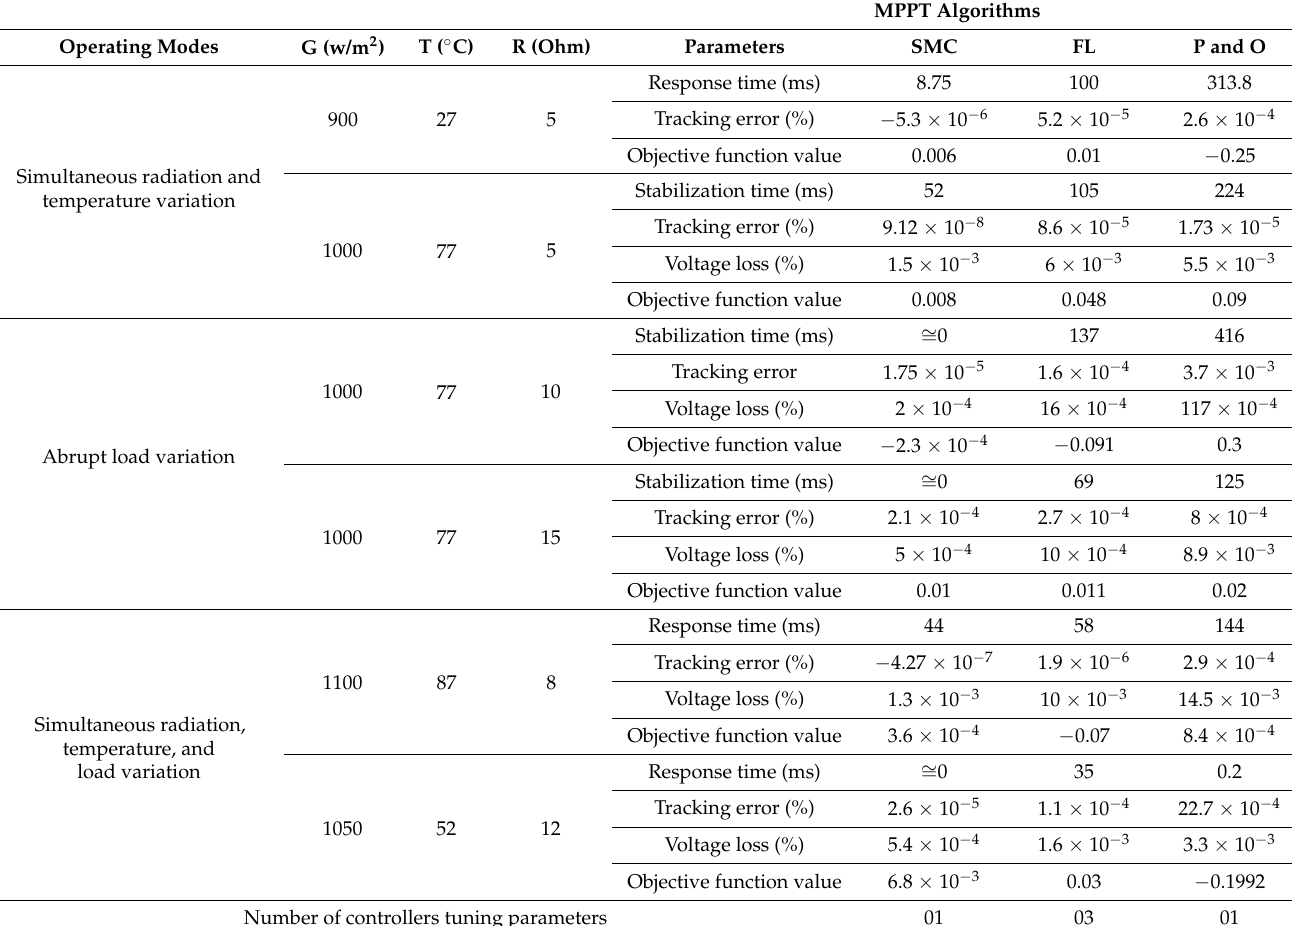
Table 2. Comparative study between the three MPPT